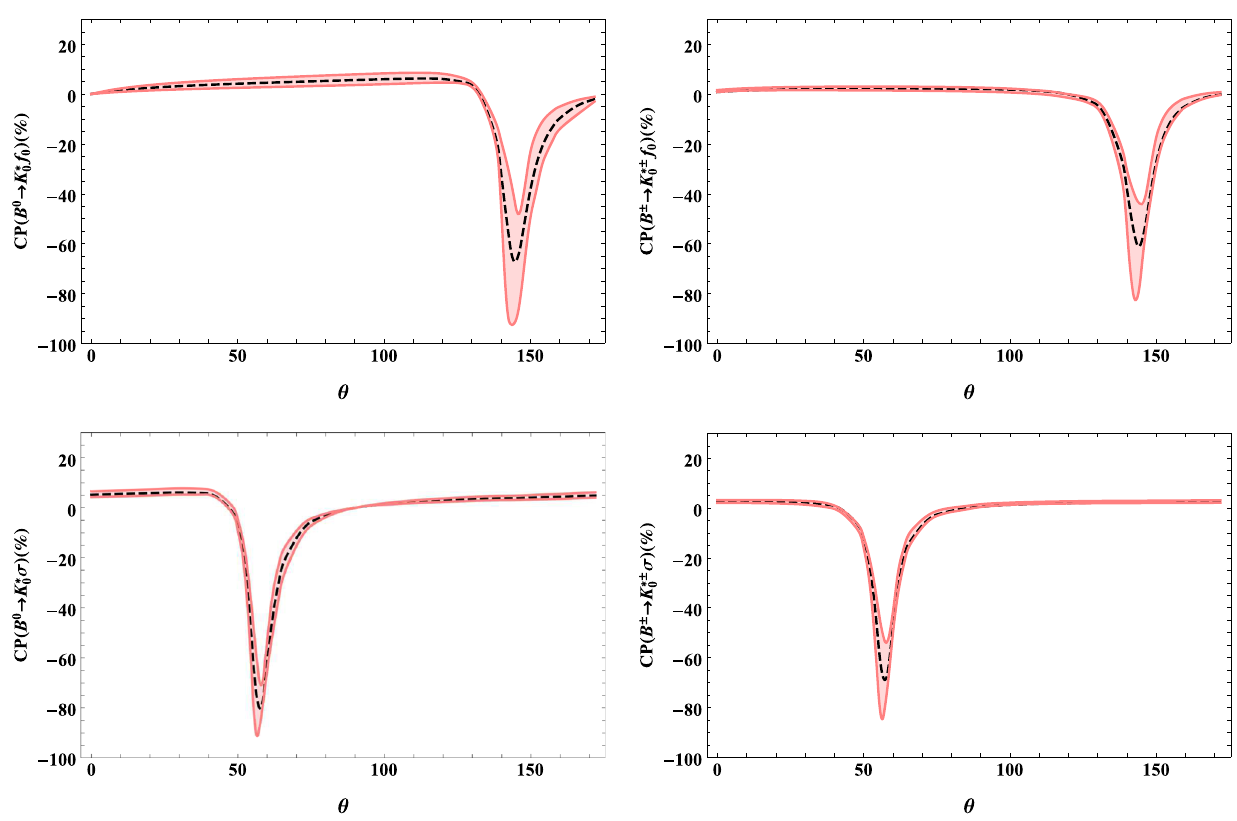
σ with variant of the mixing angle θ f 0 and B → K ∗ 0 2